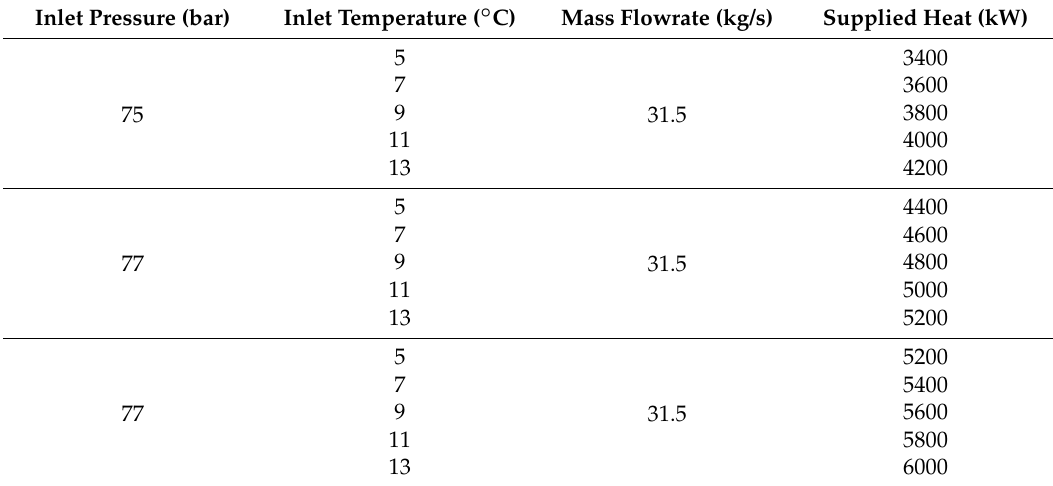
Table 3. Simulation conditions for constant pressure case.